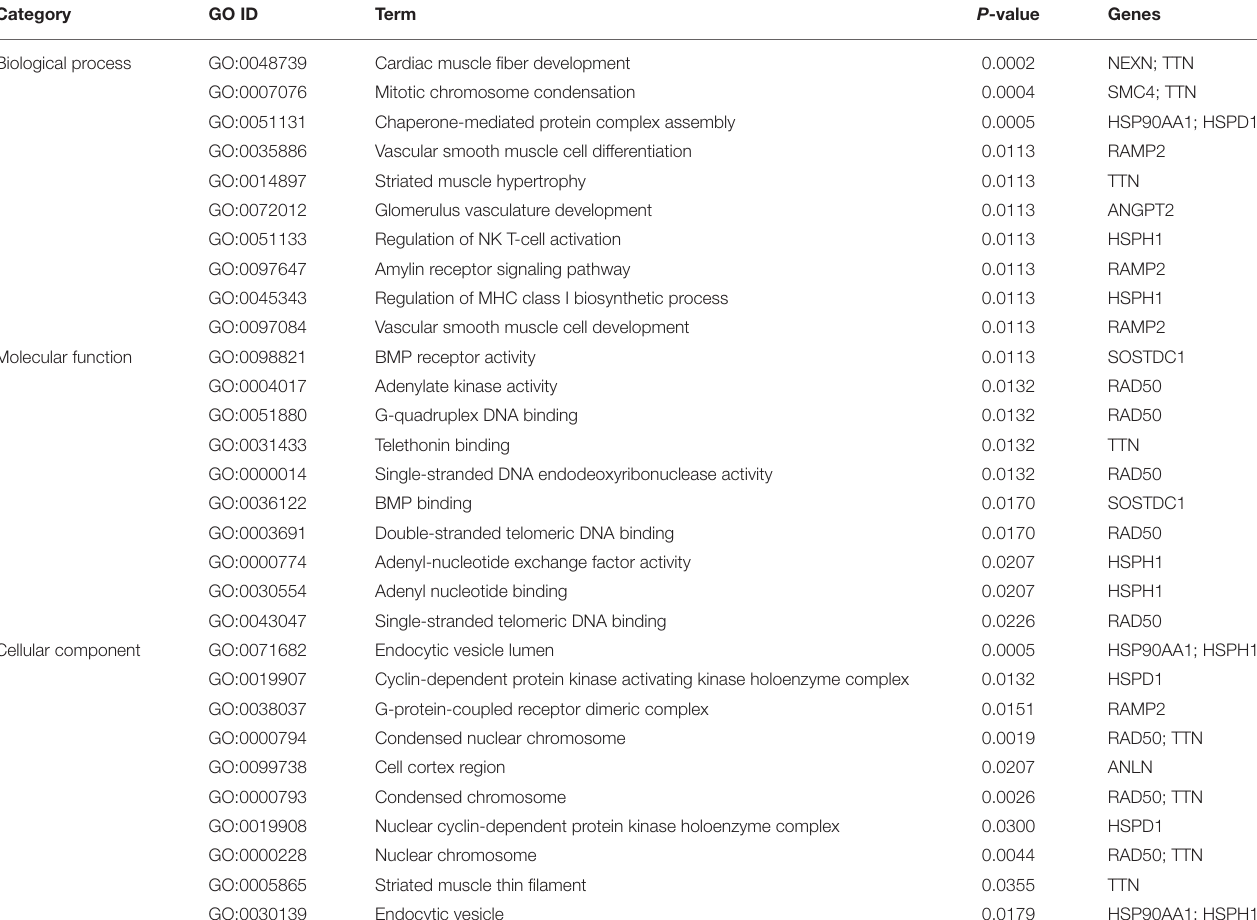
TABLE 1 | Gene set enrichment analysis for differentially expressed genes detected from the microarray data of lung tissue with patients with pulmonary arterial hypertension (PAH).